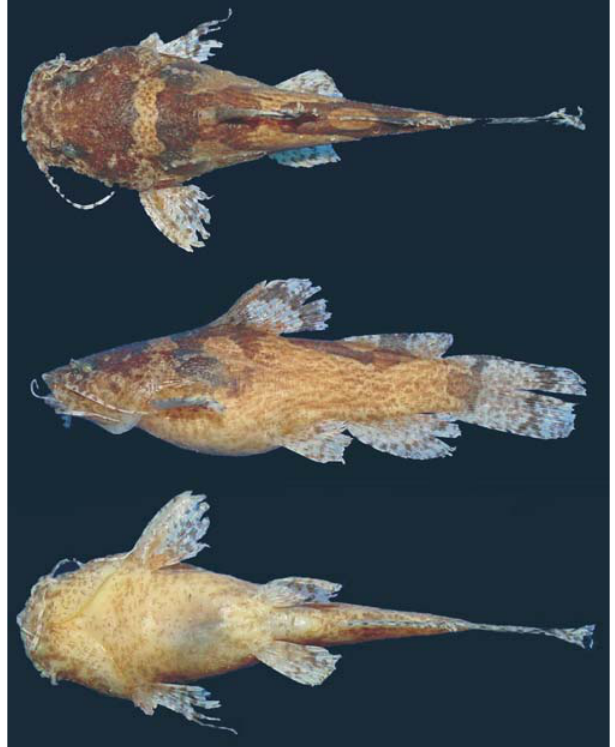
Fig. 2. Microglanis garavelloi , paratype, MZUEL 3288, 28.2 mm SL, ribeirão Pau D´alho, São Paulo, Brazil.